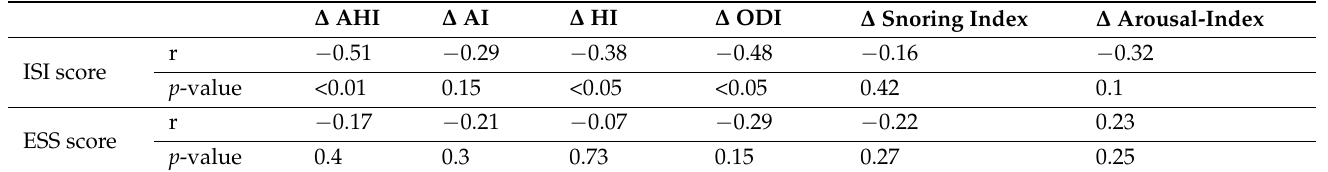
Table 3. Correlation coefficients between the preoperative ISI-score and ESS-score and the various differences ( ∆ ) in the pre- to post-operative PSG-metrics.